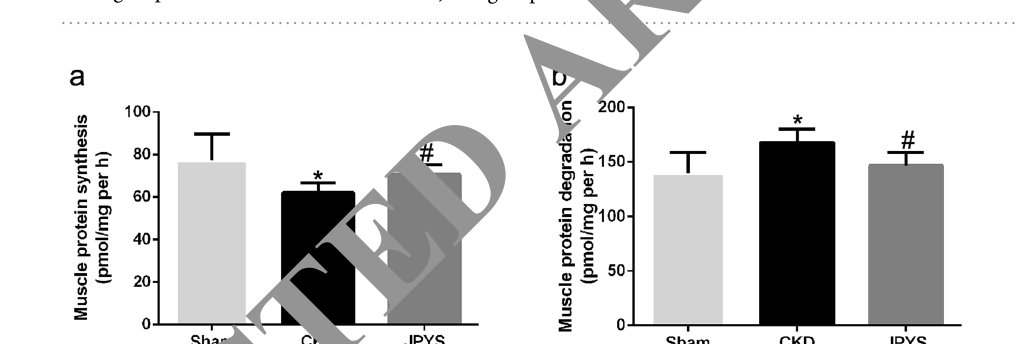
Figure 1. Effect of JPYS decoction on body weight, muscle wet weight and muscle fibre cross-sectional area in 5/6 nephrectomised rats. ( a ) Body weight. ( b , c ) Weight of the gastrocnemius and tibialis anterior muscles was normalized by tibia length. ( d ) HE staining of the TA muscle. Scale bar = 100 μ m. ( e ) Average fiber size of the HE-stained TA muscle. Results are presented as mean ± SD, n = 10 per group, a P < 0.05, b P < 0.001 between Sham and CKD groups, c P < 0.05 between CKD and JPYS groups; * P < 0.05, *** P < 0.001 between Sham and CKD groups. # P < 0.05 between CKD and JPYS groups.